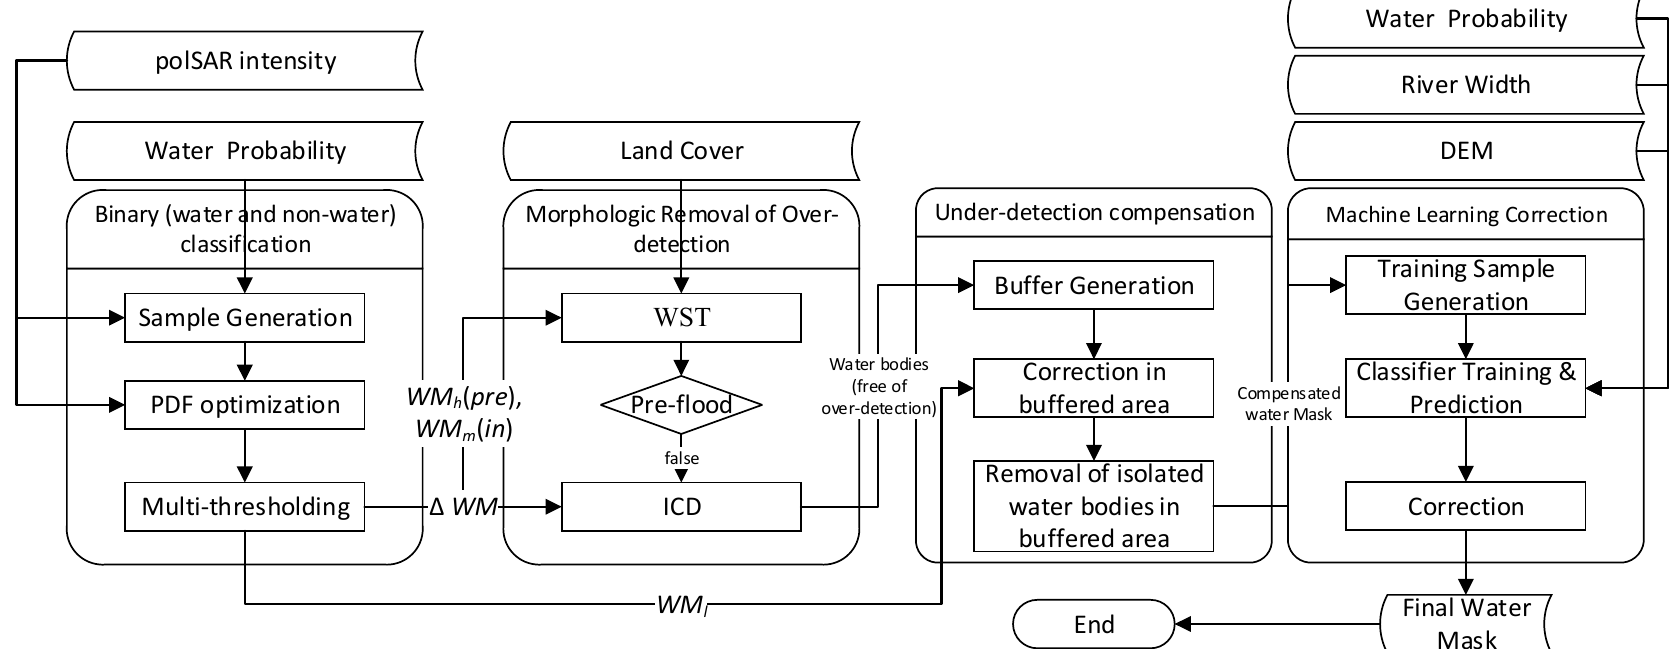
Figure 3. The workflow of RAPID. From the left to the right panels are step 1 (binary classification), 2 (morphological processing consisting of water source tracing (WST) and improved change detection (ICD), 3 (multi-threshold compensation) and 4 (machine-learning-based correction), respectively.